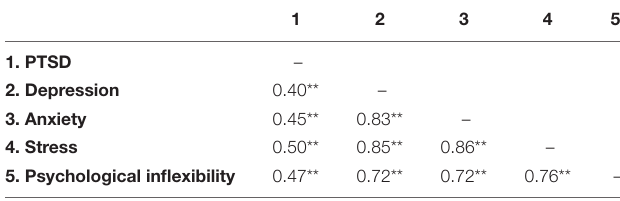
TABLE 2 | Correlations among PTSD, mental health, and psychological